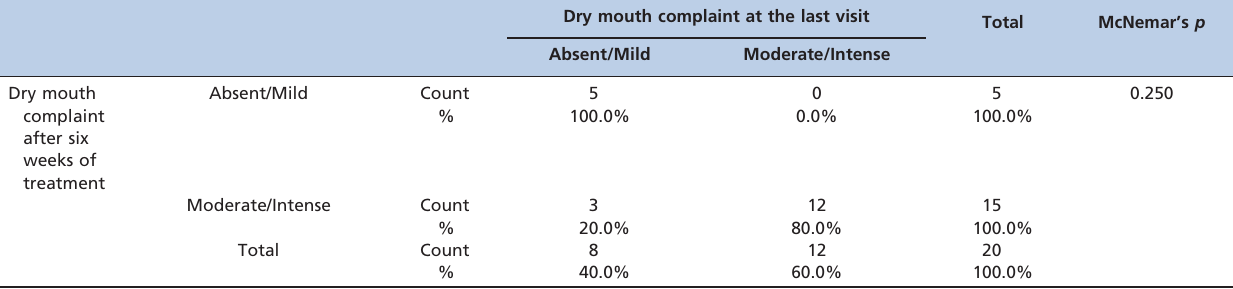
Table 4 - Comparison of dry mouth complaints after six weeks and at the last